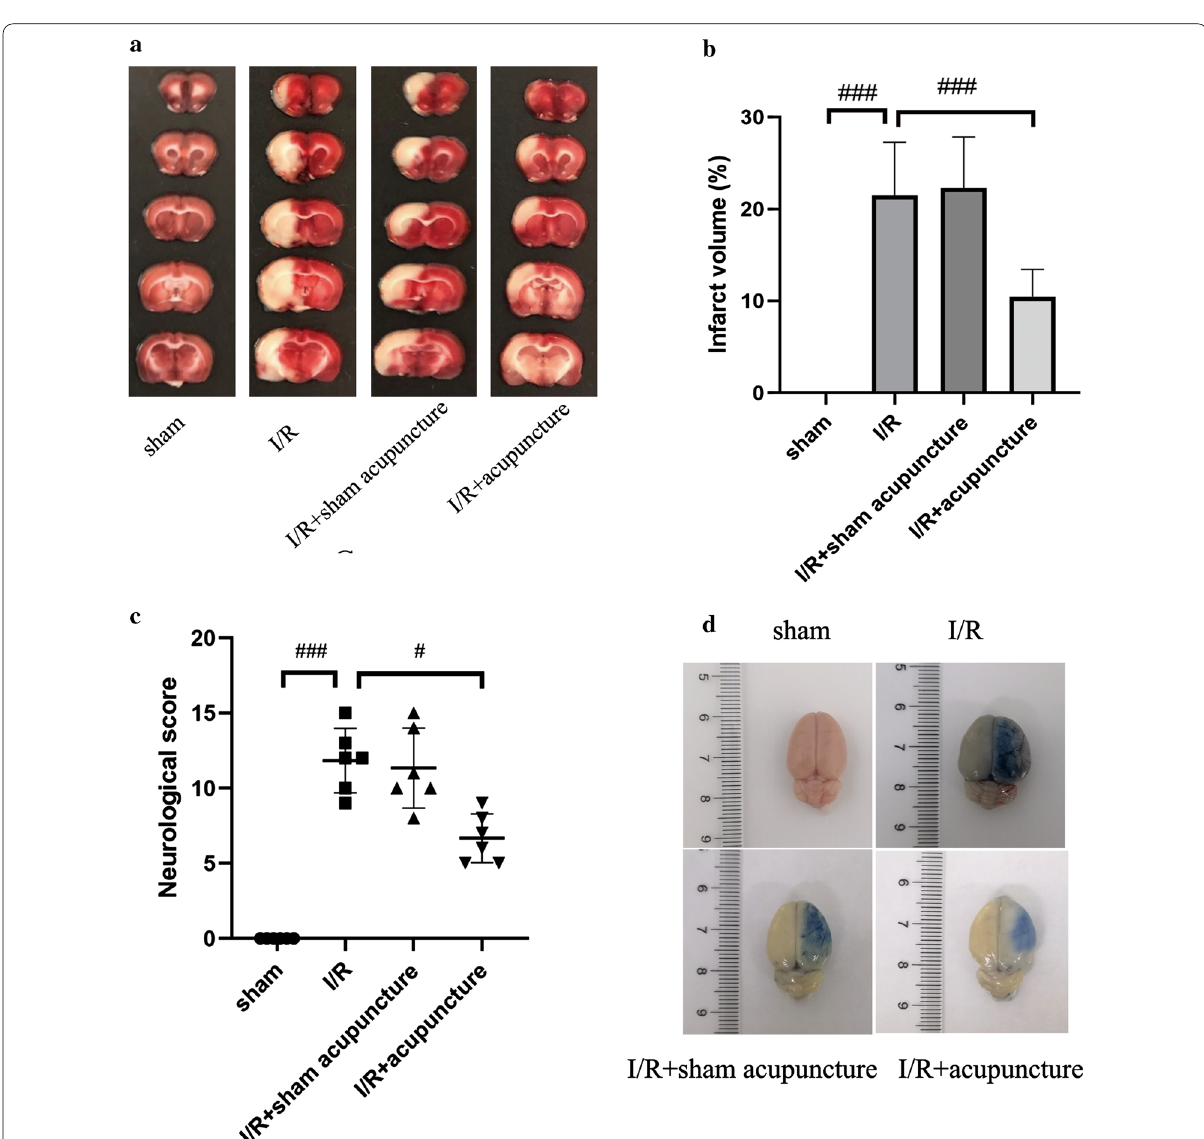
Fig. 2 Effect of acupuncture on cerebral ischemia–reperfusion (I/R) injury. a , b TTC staining was performed to determine the infarct volume of rats at 72 h after reperfusion in the four groups (sham, I/R, I/R of the infarct hemisphere. c The neurological deficits were evaluated by neurological score at 72 h after reperfusion. Neurological scores are presented as median (interquartile range). Results represent at least three independent experiments. d Blood brain barrier leakage was detected by Evans blue staining. Each experimental result was presented as mean